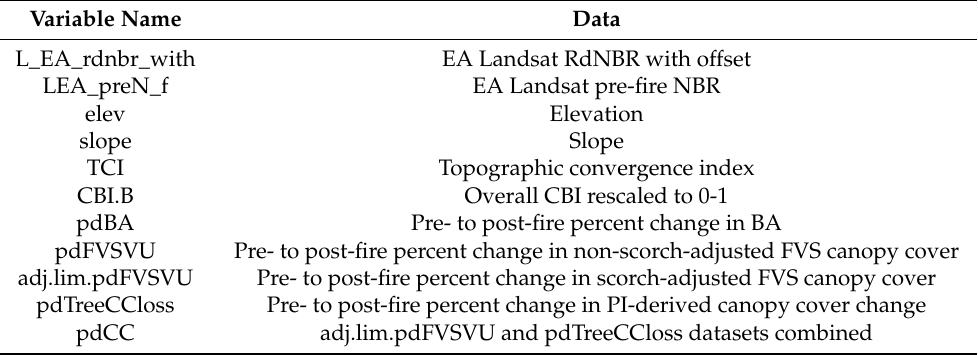
Table A4. Dictionary of variables used in multivariate